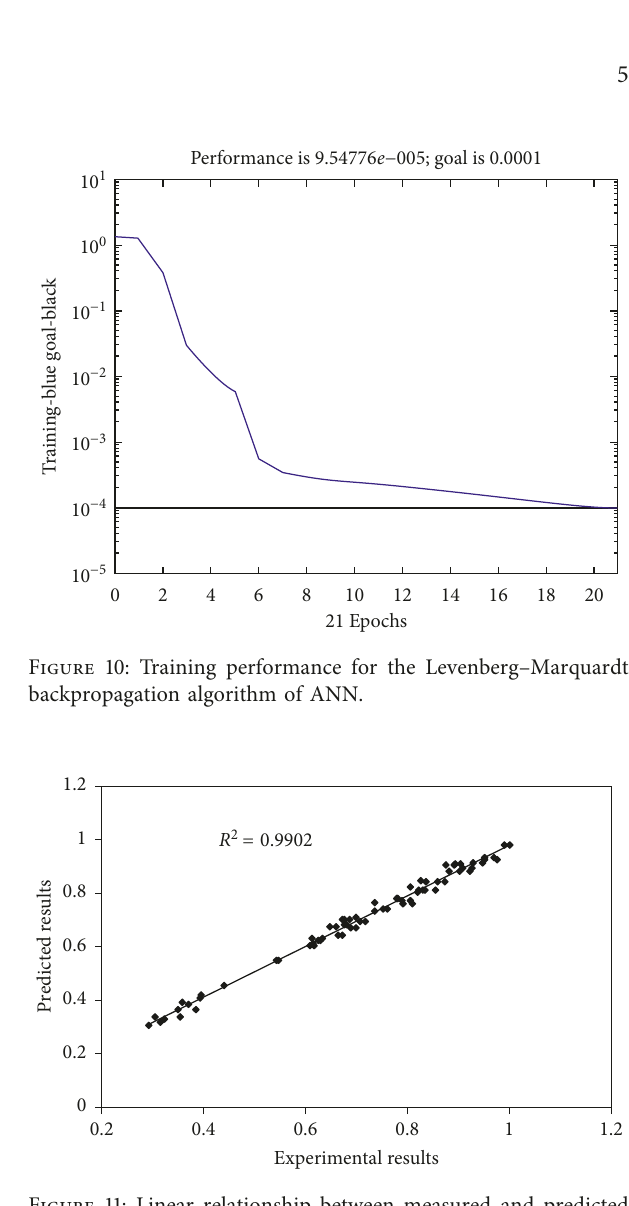
Figure 11: Linear relationship between measured and predicted compressive strengths for the Levenberg–Marquardt back- propagation algorithm of ANN.